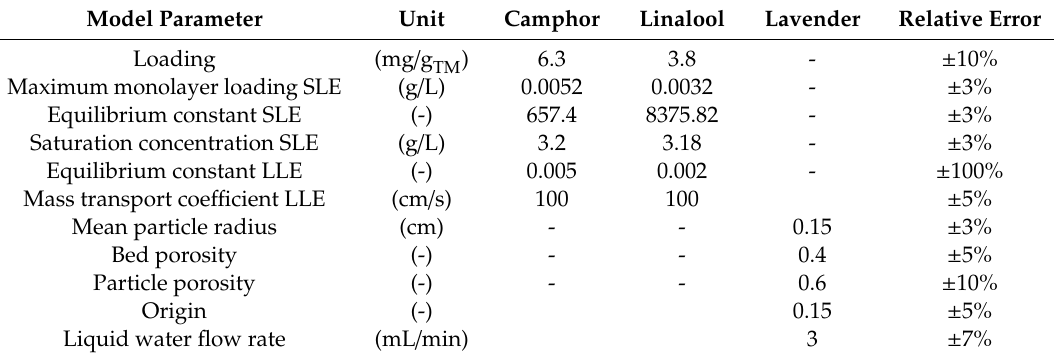
Table 6. Parameters of the accuracy and precision study of the lavender